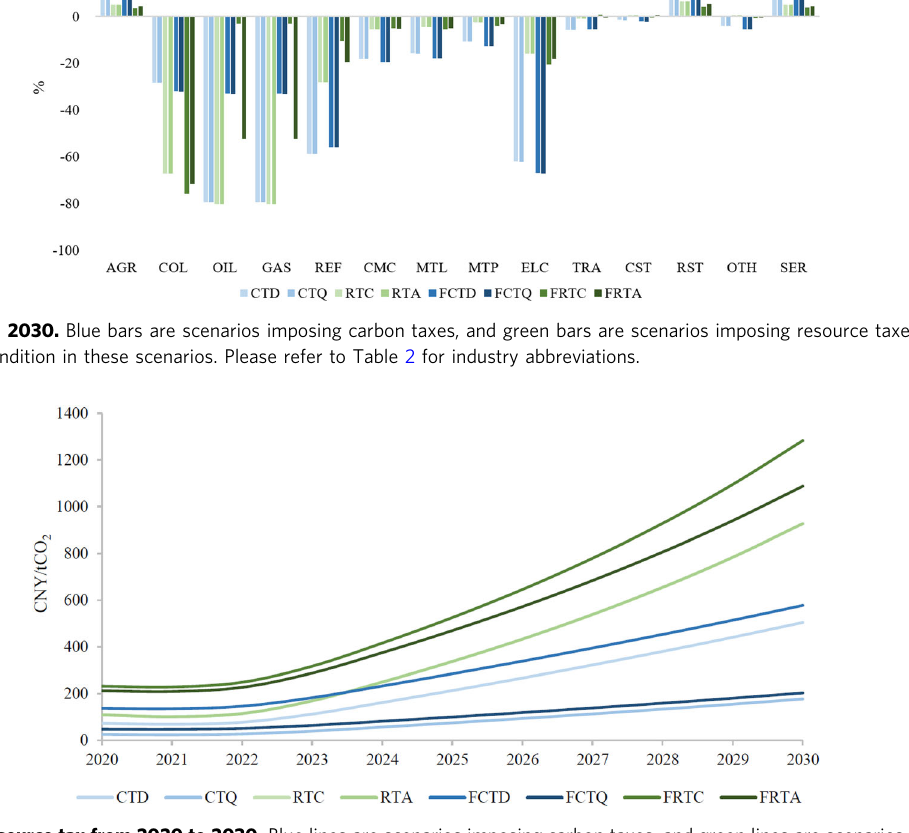
Fig. 9 Carbon tax and resource tax from 2020 to 2030. Blue lines are scenarios imposing carbon taxes, and green lines are scenarios imposing resource taxes. Deeper colors represent free market condition in these